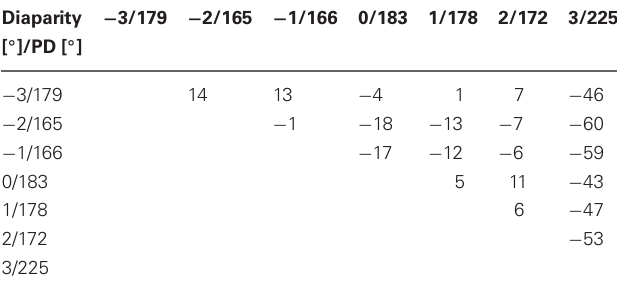
Table 1 | Pairwise differences between preferred directions of moving visual stimuli presented at different horizontal